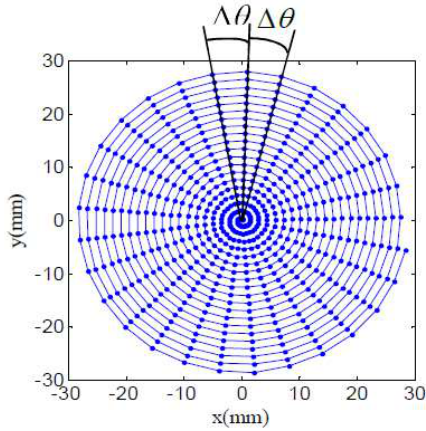
Figure 6. Constant angle cutting path.